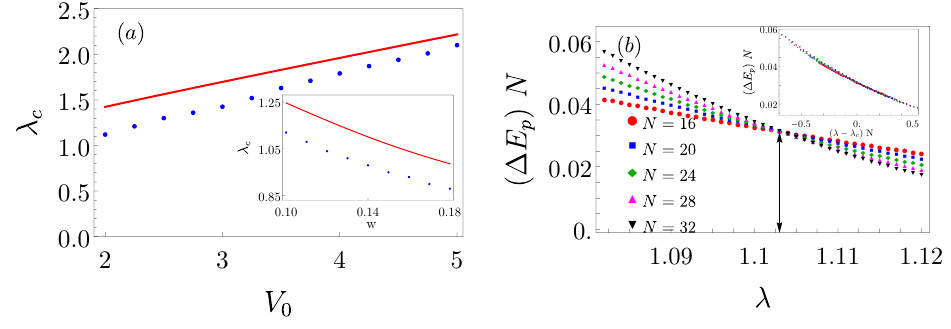
= 0.1 showing the presence of Figure 7: (a): Plot of λ as a function of V for w c 0 0 > V the transition for a wide range of V . The inset shows a plot of λ as a function c c 0 = 2. For both plots, the blue dots represent exact results obtained using of w for V 0 ED while the red lines shows the analytical result obtained using Eq. 29. (b) A plot ) N z as a function of λ for different N showing a crossing at λ ≃ 1.104 for of ( ∆ E p c ) N z as a function of ( λ − λ ) N 1 /ν showing data z = 1. The inset shows a plot ( ∆ E p c collapse for z = ν = 1. These plots indicate that the Van-Vleck perturbation theory captures the essence of the Ising transition. All energies are scaled in units of ∆ . See text for